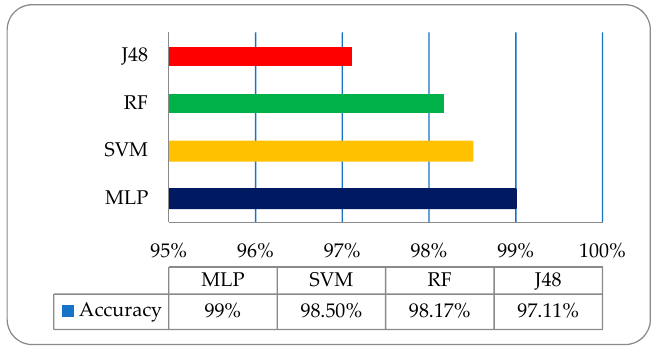
Figure 8. The overall accuracy graph of the employed ML classifiers on the fused dataset.